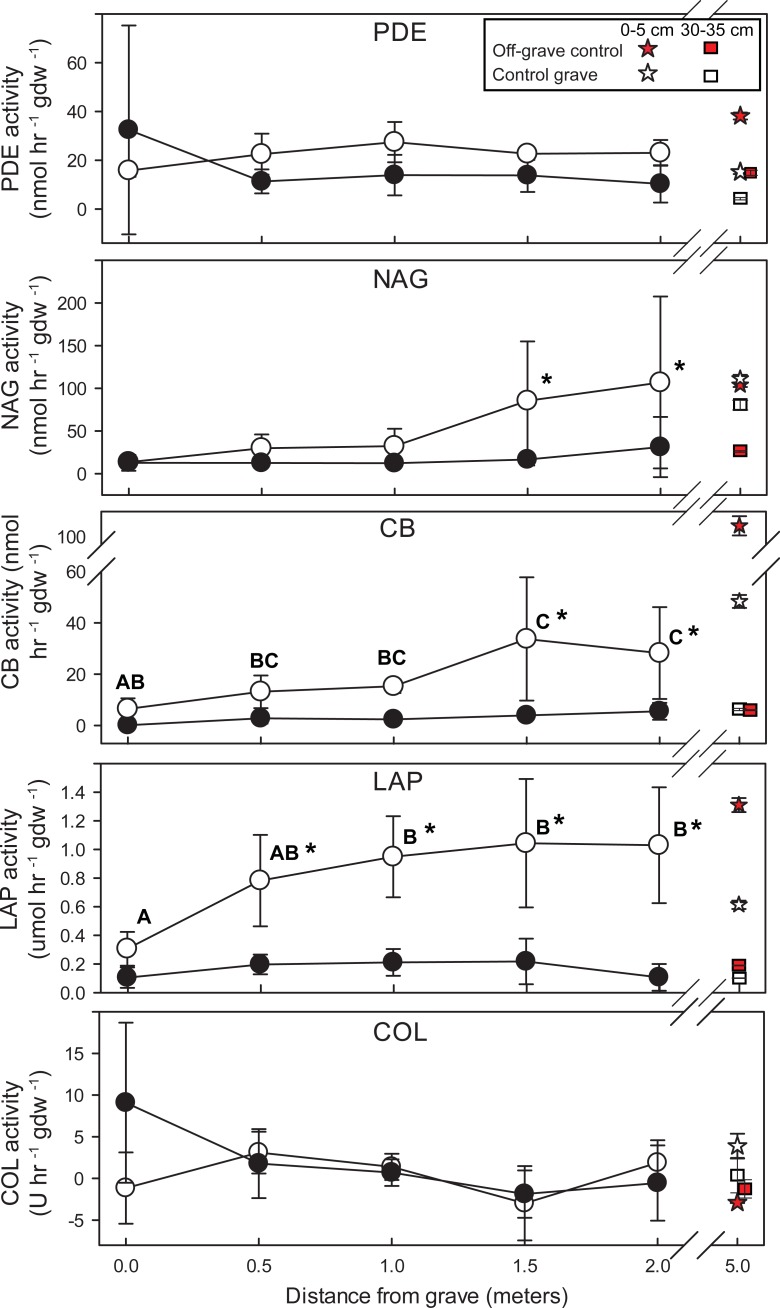
Potential extracellular enzyme rates along linear transects from the grave.Points are means of n = 3 samples from three independent transects. Significant changes in enzyme activity between distances are denoted by letters. Significant differences between surface soils (0‒5 cm, open circles) and soils collected at 30‒35 cm depth (filled circles) are indicated by asterisks. Measurements from off-grave site and control grave are included for reference. PDE = phosphodiesterase activity; NAG = N-acetyl-β-glucoseaminidase activity; CB = β-D-cellulobiosidase activity; LAP = leucine aminopeptidase activity; COL = collagenase activity.